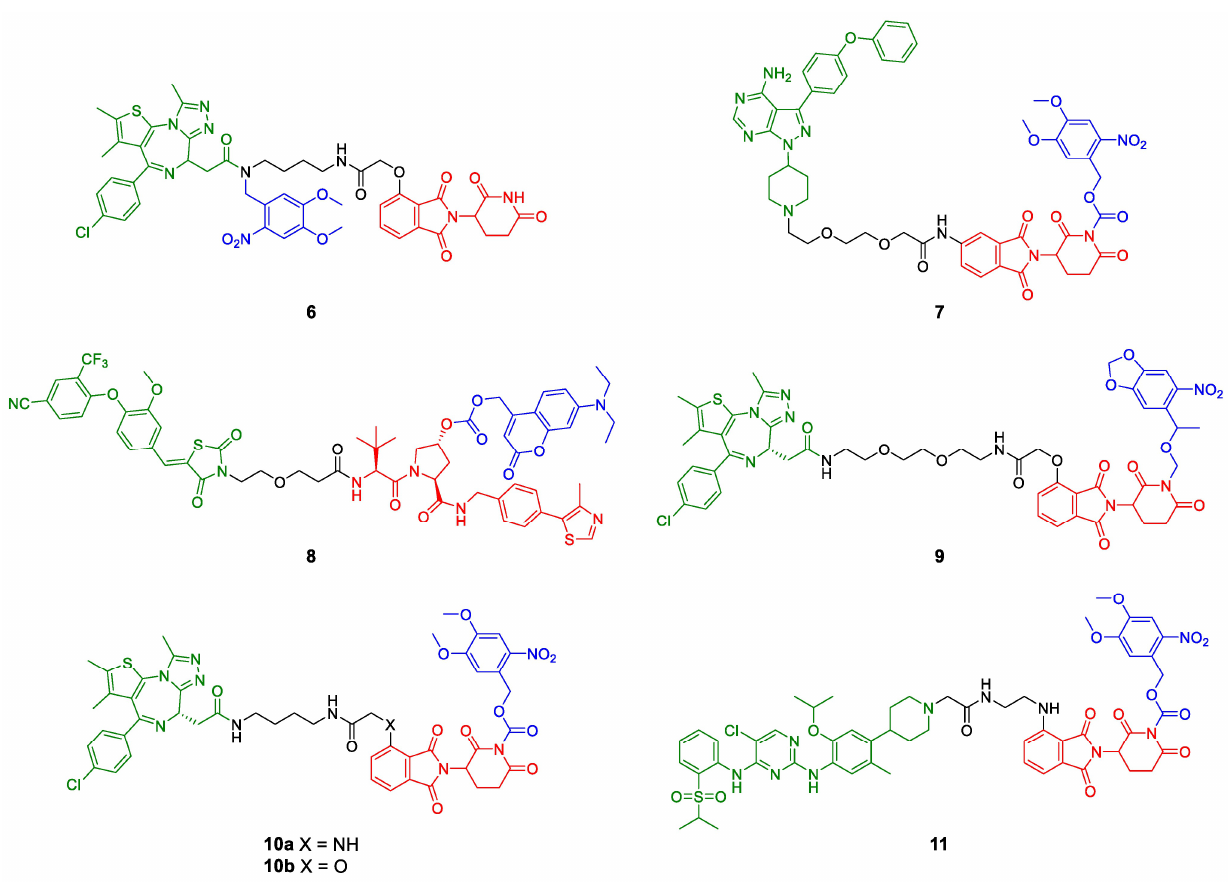
Figure 7. PROTACs with photocleavable moieties (blue). Bulky groups are added to functional PROTACs either at the POI ligand (green, 6 ) or the E3 ligase ligand (red, 7 – 11 ) and prevent or impair binding. Upon irradiation at a defined wavelength, the light-responsive moieties are cleaved, and the active degrader is released.